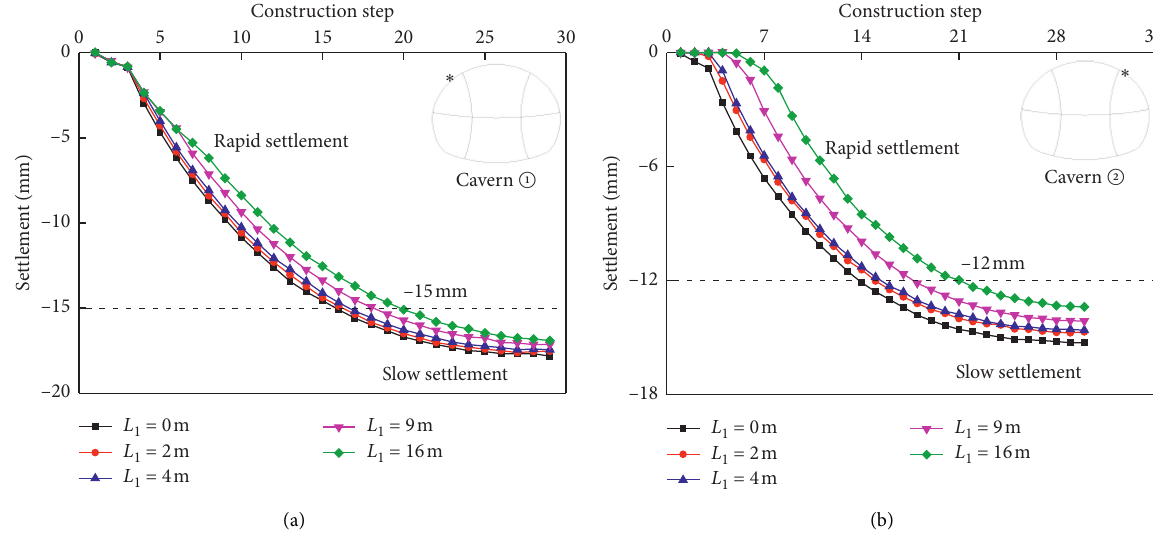
Figure 4: Vault settlement characteristics of CK9+462 section. (a) Vault settlement curve of cavern ① . (b) Vault settlement curve of cavern ② .